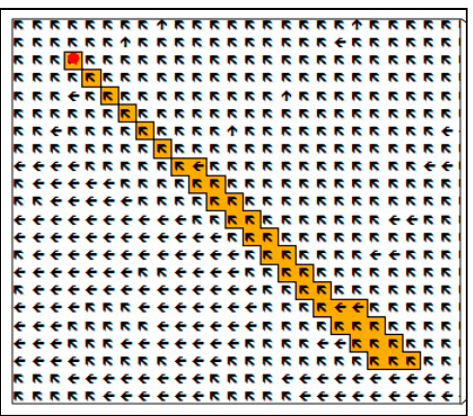
Figure 4. Example of a groundwater measuring point (red) with corresponding catchment area (orange) derived from groundwater flow directions (arrows).